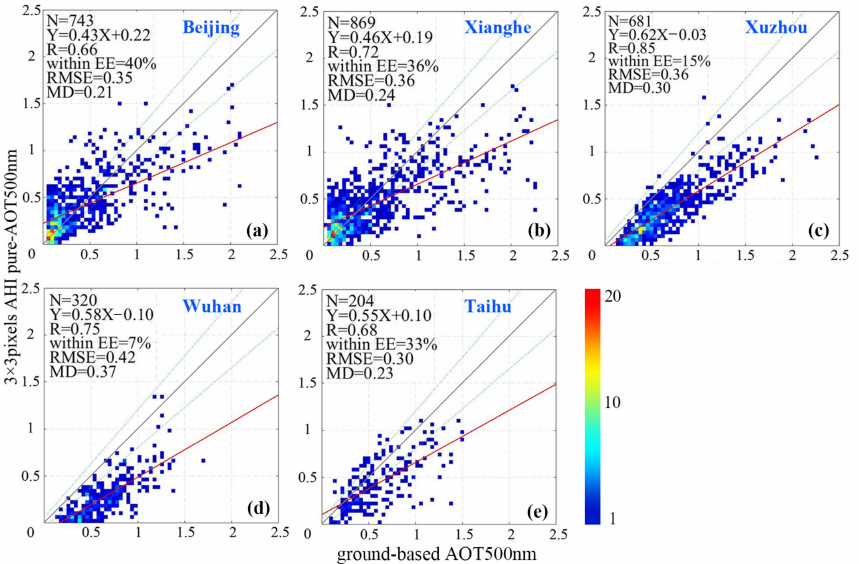
Figure 3. Scatterplots of the H8 / AHI version 010 dataset of aerosol optical thickness (AOT) pure against ground-based measurements at 500nm during 8:00–17:00 CST from September 2015 to August 2017. There are five sites: ( a ) Beijing, ( b ) Xianghe, ( c ) Xuzhou, ( d ) Wuhan, and ( e ) Taihu. The color bar indicates the number of data points, the solid red line is a linear regression, the gray solid line is the 1:1 line, and the dashed blue lines symmetrical to the grey line are the expected error (EE) envelopes. The means in text representation in the figure have been described in the evaluation metrics